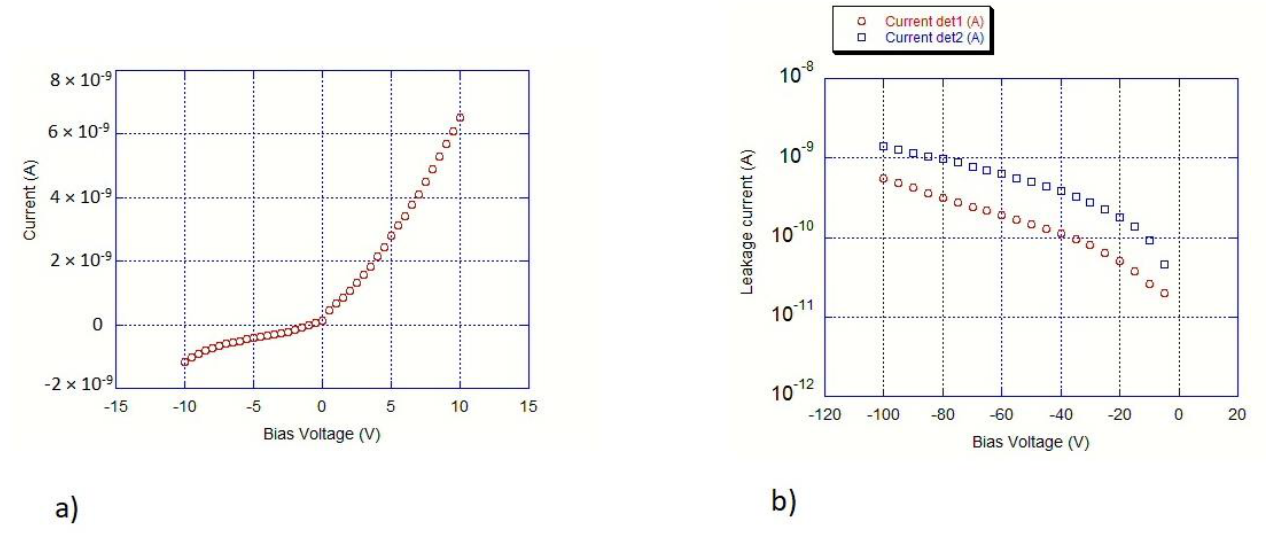
Figure 6. ( a ) I/V plot on a vertical 4 mm 2 diode where the rectifying behavior is apparent. ( b ) Reverse current versus bias voltage on two detector samples at 50 V leakage currents are 147 and 496 pA for det 1 and det 2, respectively, corre- sponding to current densities of 3.6 and 12.4 nA/cm 2 .